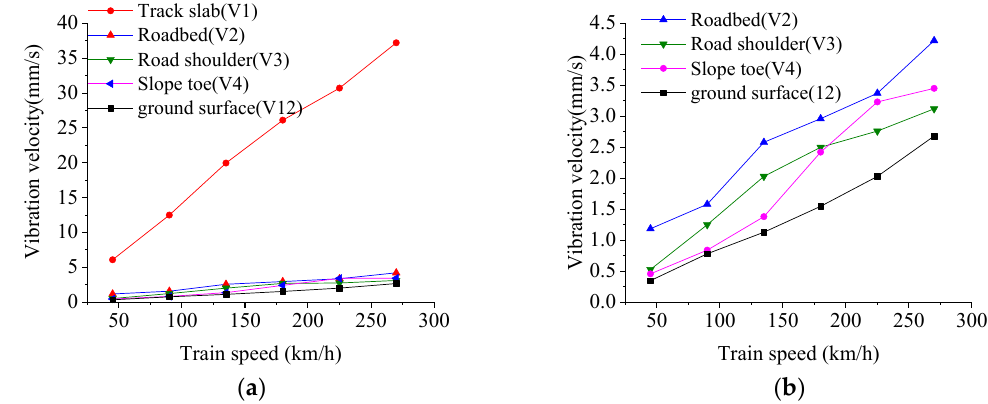
Figure 11. Relationship between the vibration velocity and train speeds in the model test. ( a ) V1, V2, V3, V4, V12, ( b ) V2, V3, V4, V12.